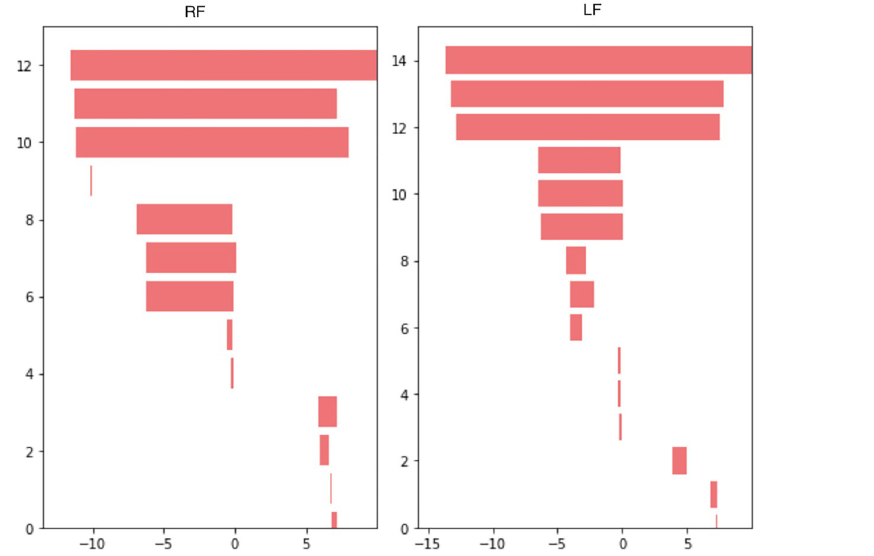
Fig 6. Persistence barcodes from the sublevel sets of the signals from Fig